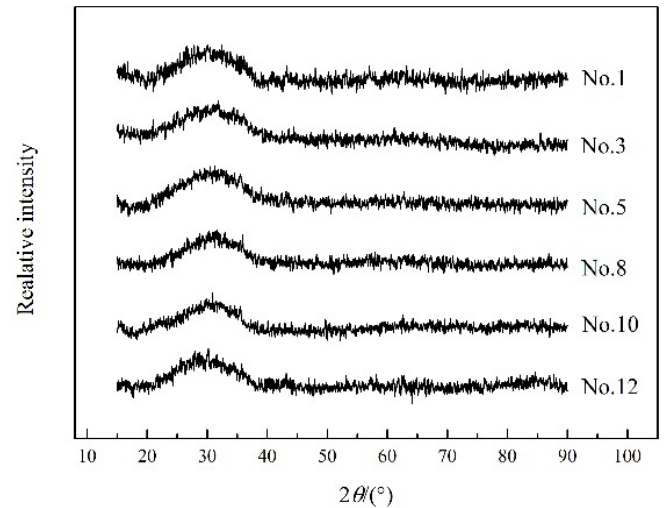
Figure 2. XRD patterns of quenched samples.